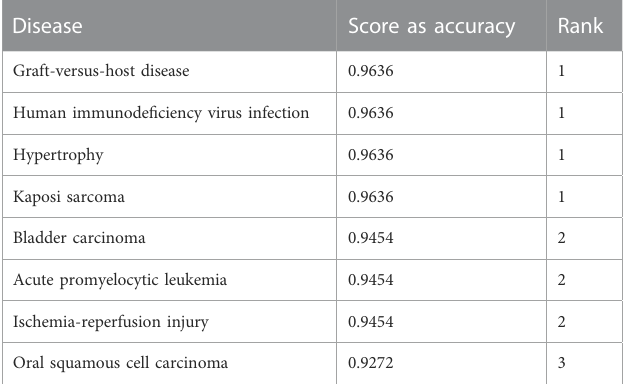
TABLE 3 An example output of the component S for the BLCA dataset. The fi rst column represents the name of the disease, the second column is the mean accuracy, and the third column is the ranking based on the second